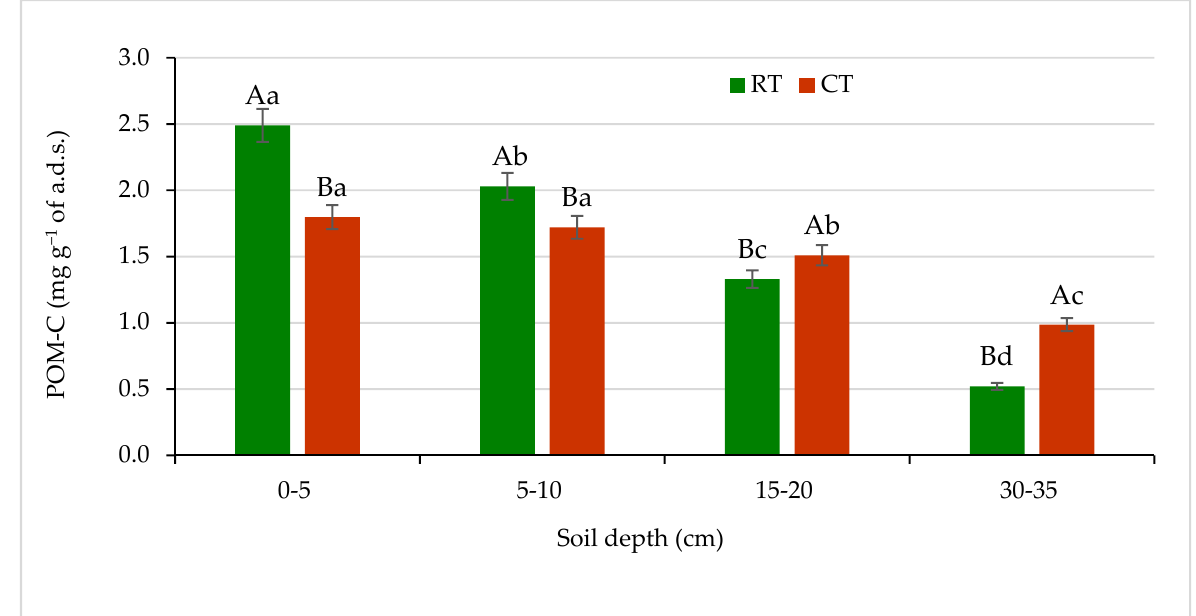
Figure 5. Content of carbon in particulate organic matter (POM-C) in soil under different tillage systems in 2018–2020 (expressed as means for the 3 years, n = 12). Different letters represent significant differences ( p ≤ 0.05) across treatments according to Tukey’s HSD test; lowercase letters within the same tillage system indicate significant differences between soil depths; uppercase letters indicate differences between tillage systems. RT—reduced tillage system; CT—conventional tillage system; n —number of samples; a.d.s.—air-dried soil. Vertical bars represent standard errors.